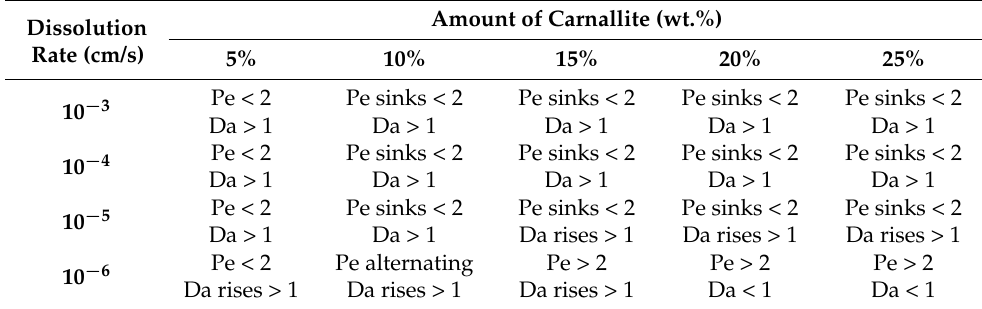
Table 2. Classification of the scenarios into diffusion-dominated (Pe < 2) or advection-dominated (Pe > 2) and reaction-dominated (Da < 1) or transport-dominated (Da > 1) systems as well as hybrid forms (Pe alternating, Pe sinks < 2, Da rises >